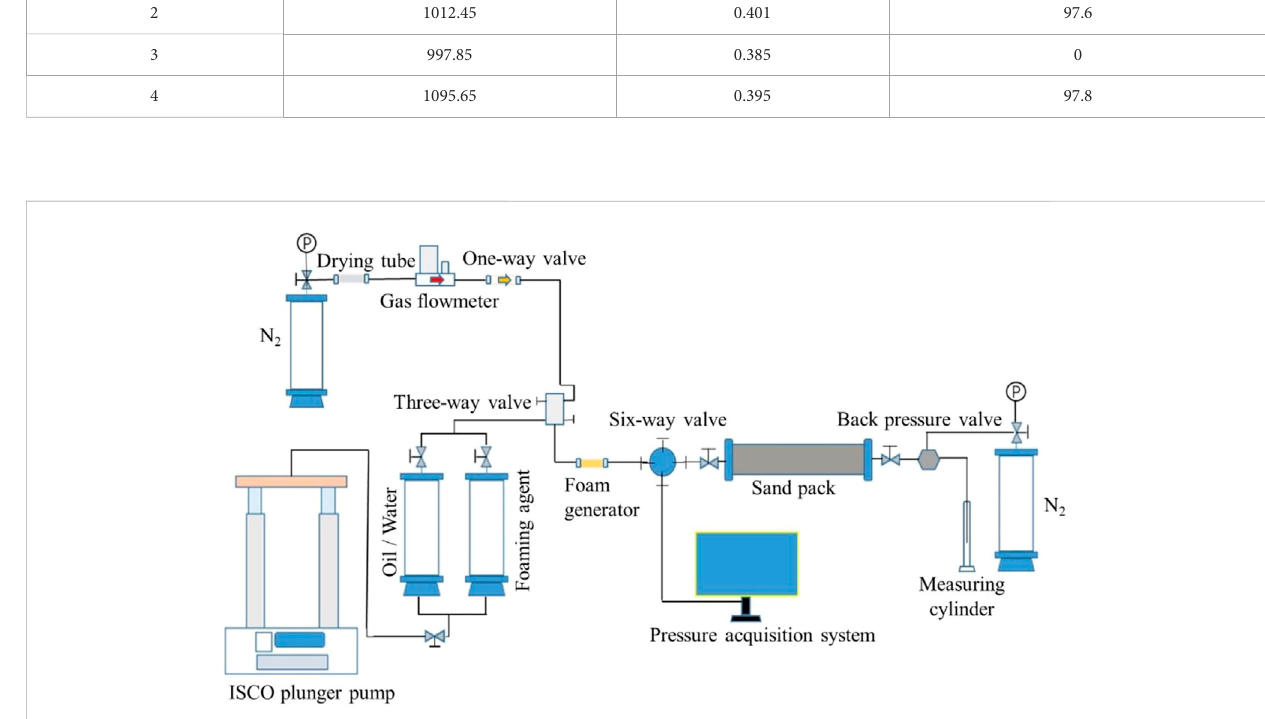
FIGURE 1 Flow diagram of the one-dimensional core tube